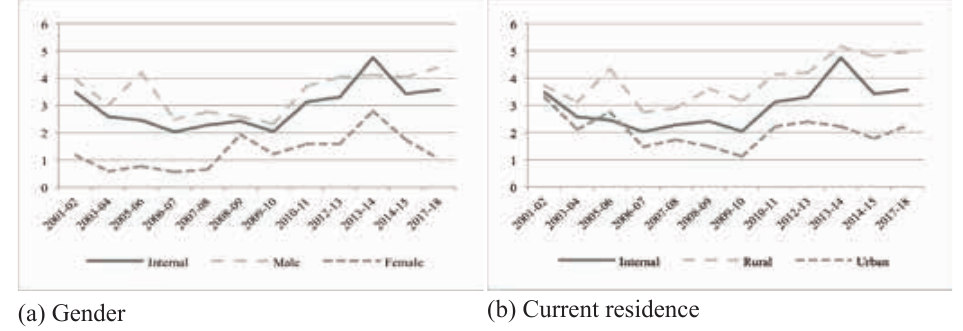
Figure 1: Trends of occupational injury rates of internal migrants (percent Source: Authors’ tabulation from various issues of LFS (2001-02 to